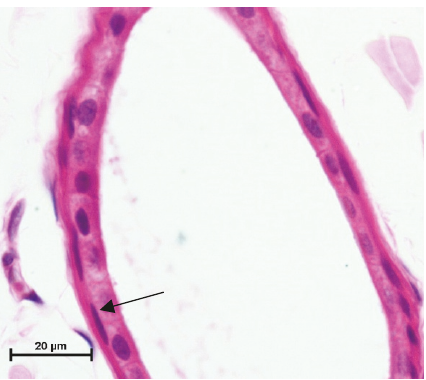
Figure 9: Photomicrograph from abdomen ventral region of skin showing myoepithelial cells (arrow) surrounding sweat gland. Hematoxylin and eosin X 1000.